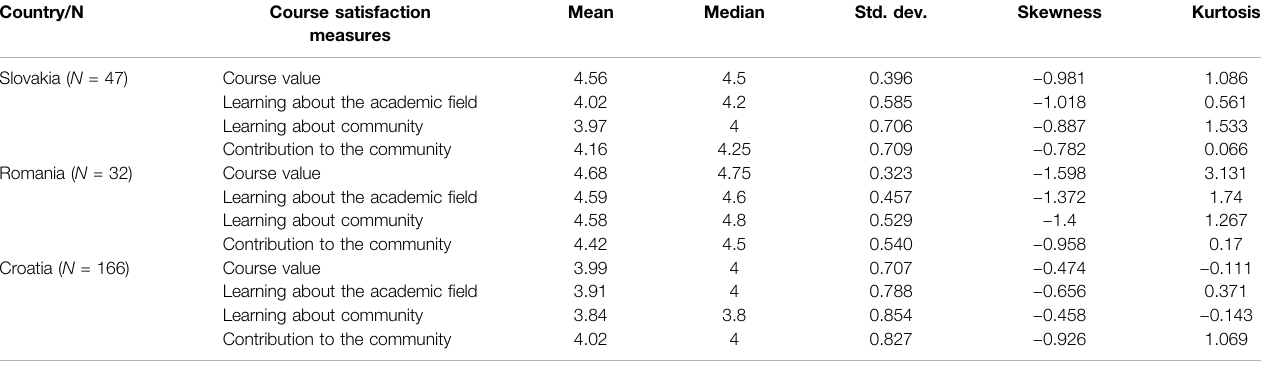
TABLE 3 | Descriptive data by countries (Slovakia, Romania, Croatia) on the four subscales of the SL-based course satisfaction measures. Country/N Course satisfaction Mean Median Std. dev. Kurtosis measures Slovakia ( N (cid:1) 47)